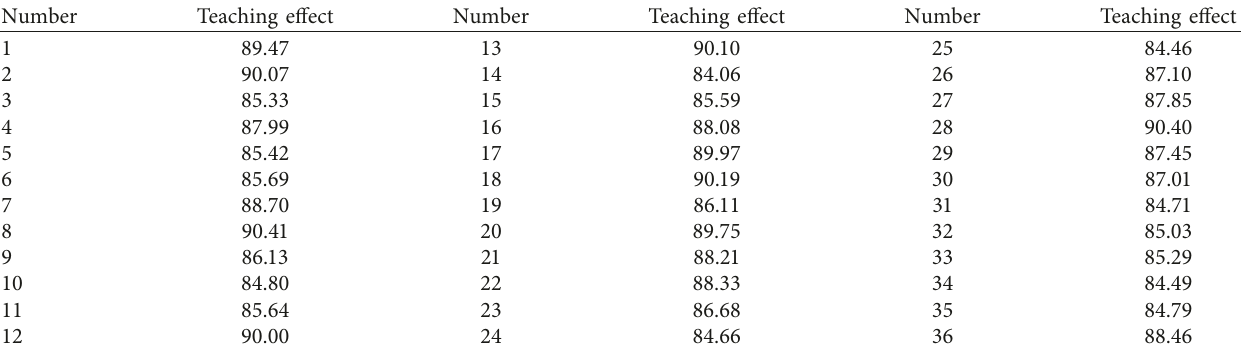
Table 2: Teaching effect verification.